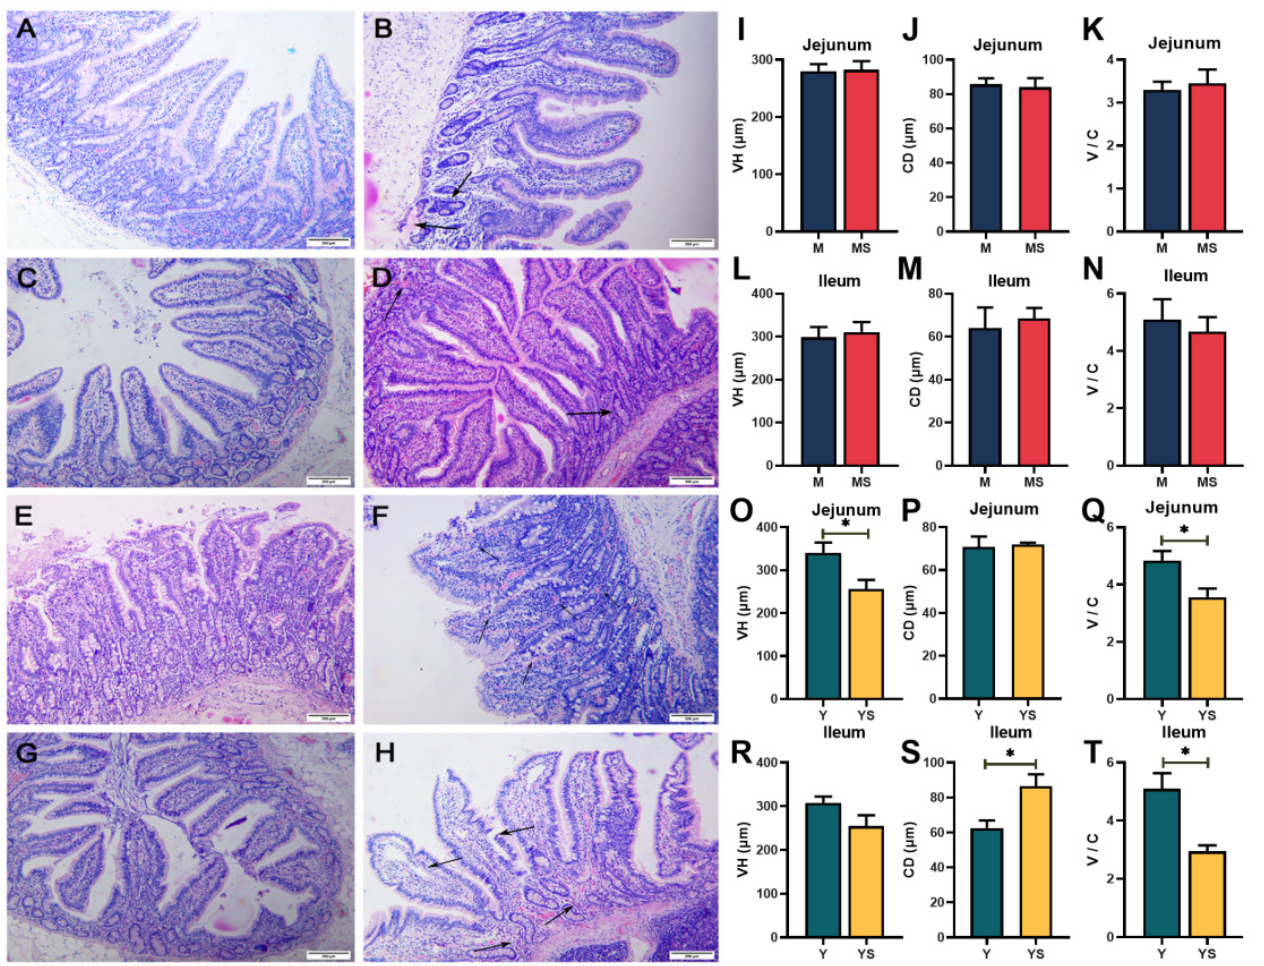
Figure 1. Effects of chronic cold stress on jejunum and ileum slices in pigs. ( A – D ) Chronic cold stress did not induce considerable harm to the jejunal mucosa and ileal mucosa of the Min pigs. ( E ) In the jejunal mucosa of the Yorkshire pigs in the Y group, no major damage was discovered. ( F ) In the YS group, the jejunal mucosa had more inflammatory changes and multiple hemorrhages, and crypt and villi were reduced. ( G ) No obvious impairment of the ileal mucosa was observed in the Yorkshire pigs of the Y group. ( H ) In the YS group, the ileal mucosa was edematous, with epithelial rupture, inflammatory cell infiltration and reduced goblet cells, and mucosal hemorrhage was visible. ( I – N ) VH, CD, and V/C in jejunum and ileum of Min pigs. ( O – T ) VH, CD, and V/C in je- junum and ileum of Yorkshire pigs. Data are presented as the means ± SEM. * p < 0.05.